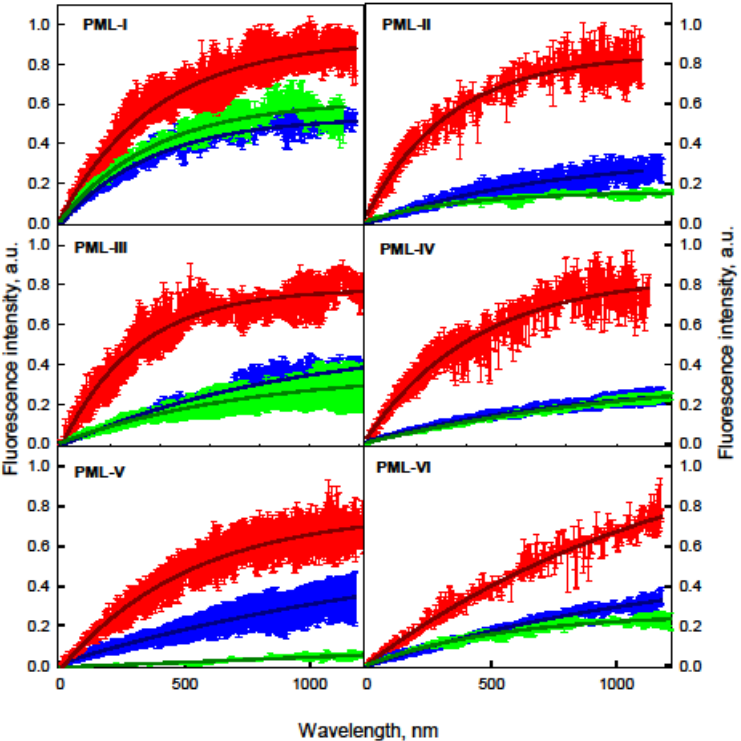
Figure 4. Curves of EGFP fluorescence recovery after photobleaching of nuclear PML isoforms in PML-bodies in U2OS cells. The curves of the photoreduction of PML isoforms in the composition of “small” PML bodies are shown in red, the curves of the photoreduction of PML isoforms in the composition of “large” PML bodies are shown in blue, and the curves of the photoreduction of PML isoforms in the composition of APBs are shown in green. Solid curves represent the approximation of FRAP data in the framework of the mono-exponential approximation. The standard deviation of the data is passed by error bars of the corresponding color.